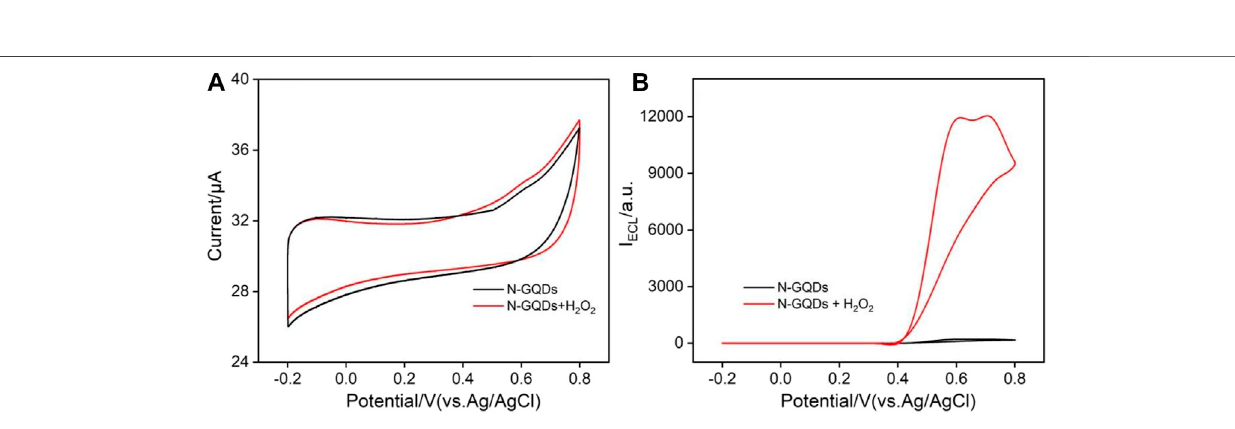
Figure S3 in SI). Stretching vibrations of C-O (1,050 cm − 1 ), C (cid:2) O (1,625 cm − 1 ), C-N (1,400 cm − 1 ), and O-H (3,434 cm − 1 ) indicate hydroxyl and amide groups on N-GQDs. Figure 3 shows cyclic voltammogram (CV) and ECL – voltage curves of N-GQDs (50 μ g ml − 1 ) in the absence or presence of